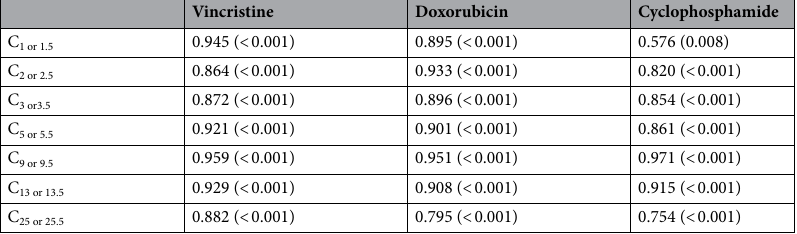
Table 4. Correlations between AUC 1–25 or 1.5–25.5 and plasma concentration at each sampling point for each cytotoxic anticancer drug. Values are expressed as Spearman’s rho values ( P values). AUC n1–n2 , area under the